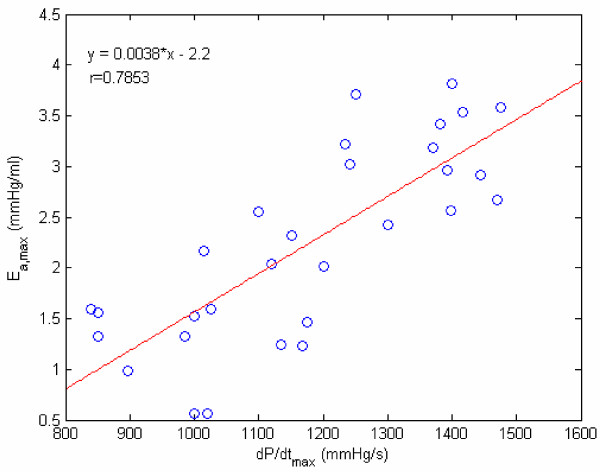
Ea,max vs dP/dtmax .Relating our contractility index Ea,max to the traditional contractility index dP/dtmax, with r being the correlation coefficient.